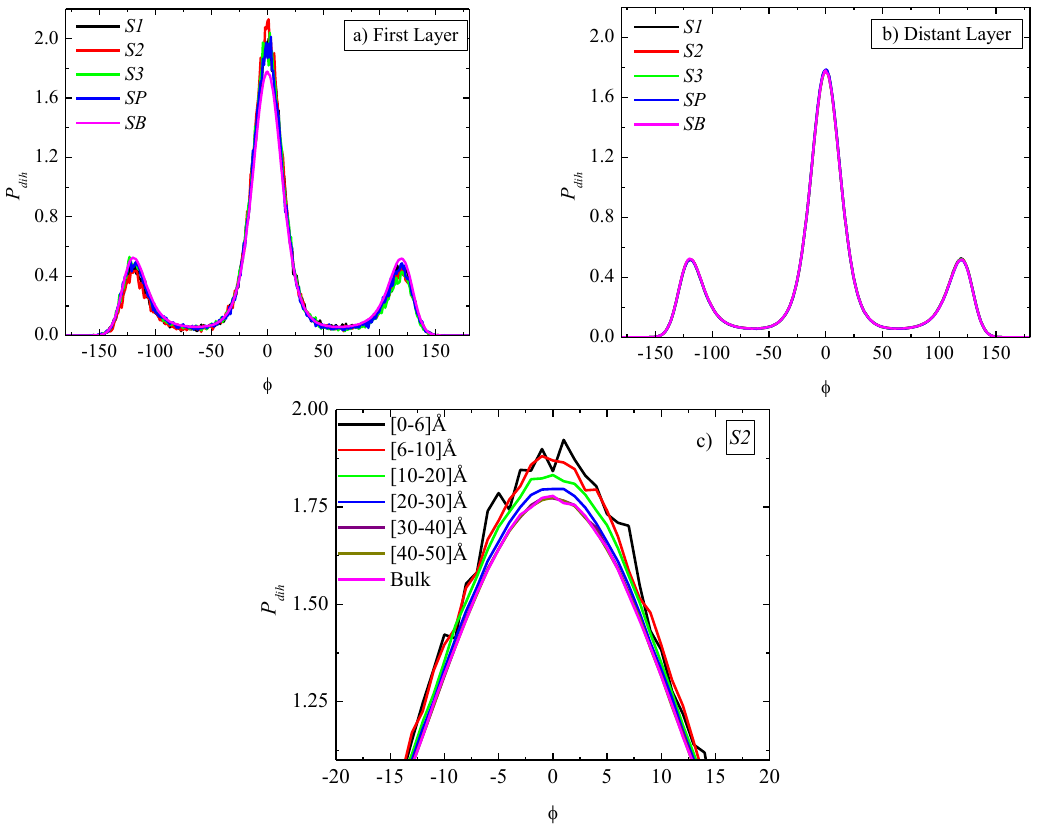
Figure 5. Torsional angles distribution as a function of R distance (distance from the center of the graphene layer). ( a ) Data for the first adsorption layer ( R = 0.6 nm) for all systems; ( b ) Data for the last adsorption layer (distant layer) ( R = L BOX / 2) for all systems; ( c ) Magnification for all spherical shells of the (S2) system. In all cases the corresponding bulk curve is